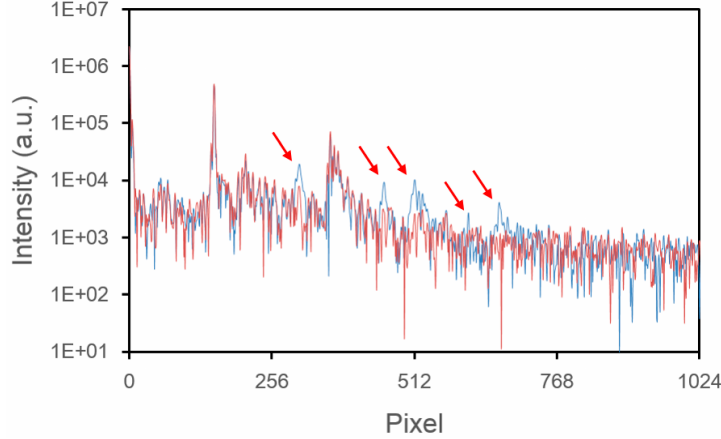
Figure 4. Fourier transforms of the saturated (blue) and compensated (red) spectra from Figure